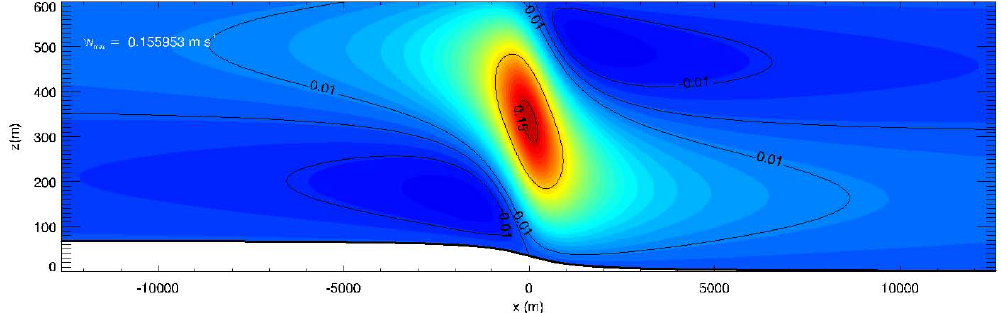
Fig. A1. Vertical velocity relative to the slope-following wind induced by a ramp in a stably stratified flow for a vertical atmospheric